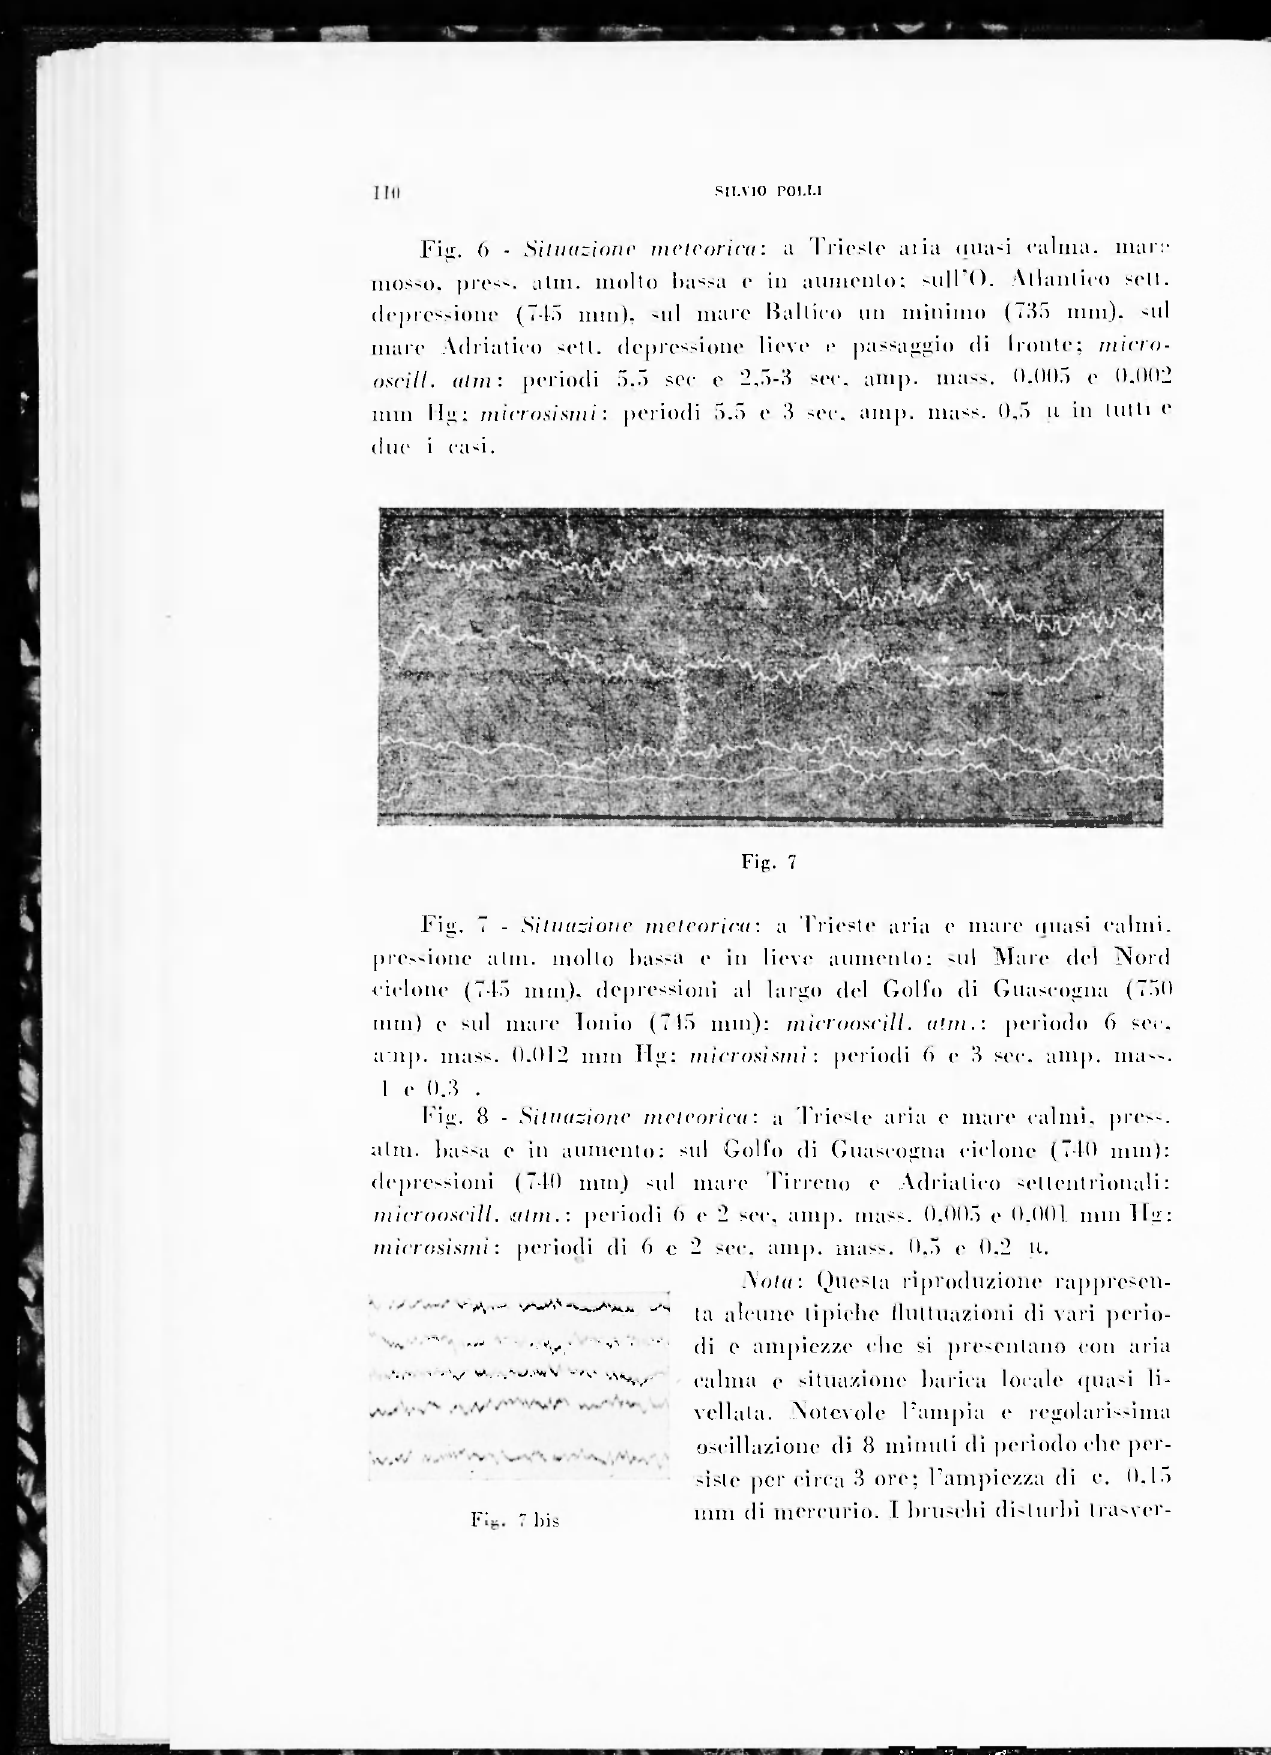
Fig. 6 - Situazione meteorica :